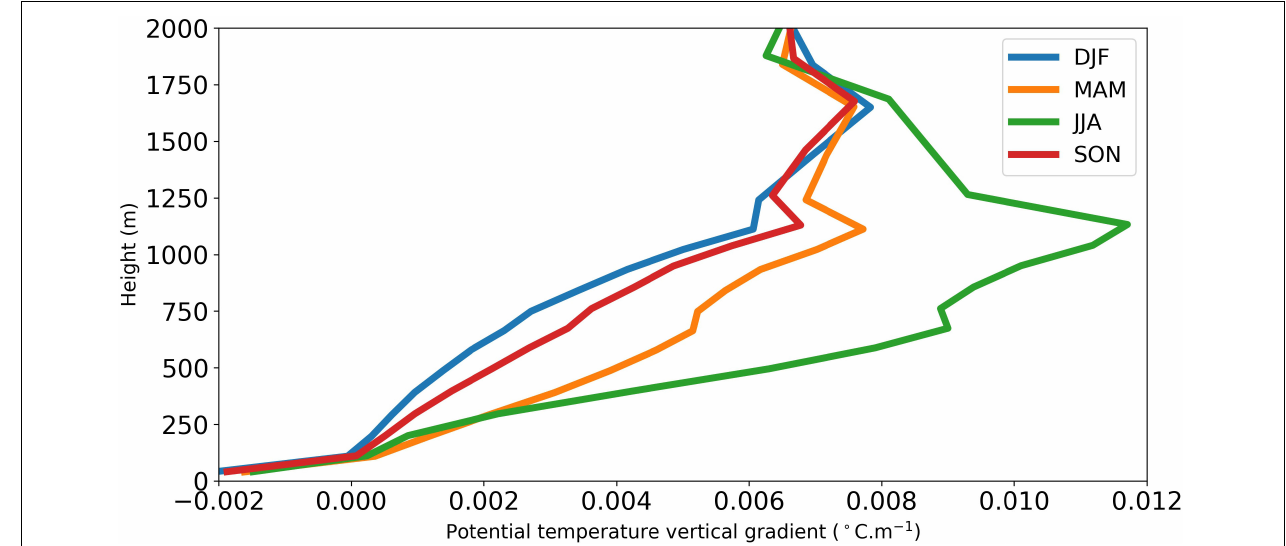
FIGURE 4 | Mean (1983–2017) seasonal potential temperature vertical gradient at point 3 ( Figure 1B ).